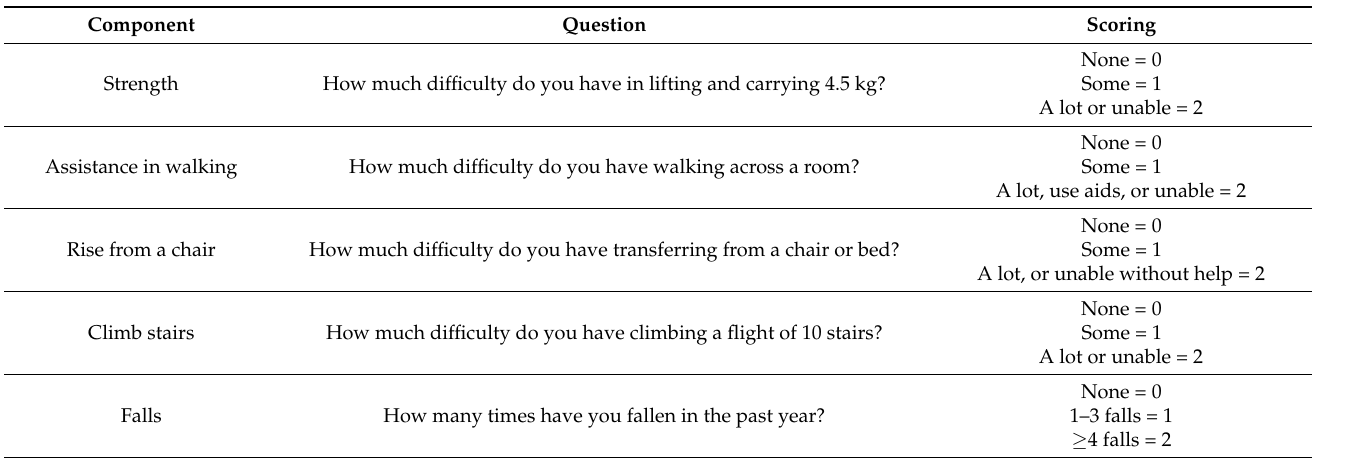
Table 1. SARC-F score.